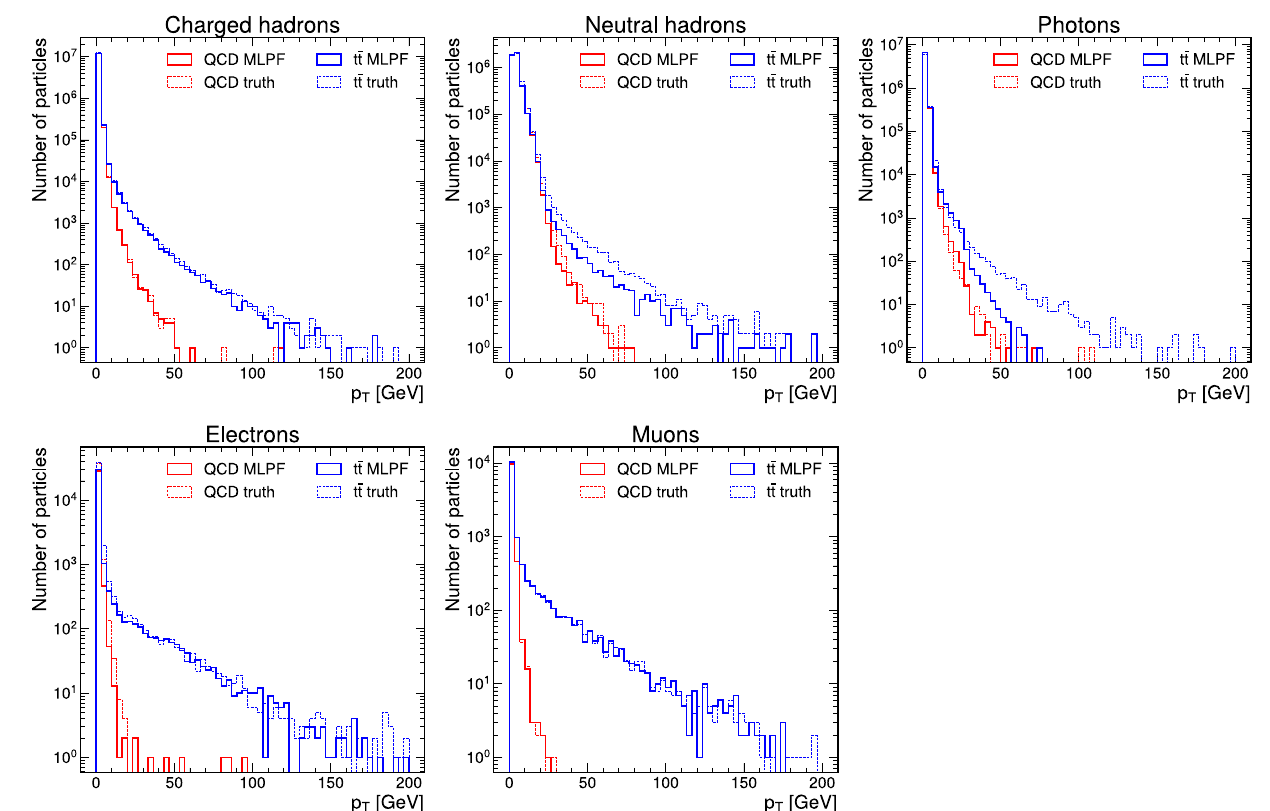
Fig. 4 The MLPF reconstruction compared to thetruth-level p T distri- butionfortheQCDvalidationsampleandthett sampleusedfortraining. The differences between the MLPF and truth distributions are a mea- sure of the prediction error. Charged hadrons, electrons, and muons are identified based on tracks with no misidentification or loss of efficiency,